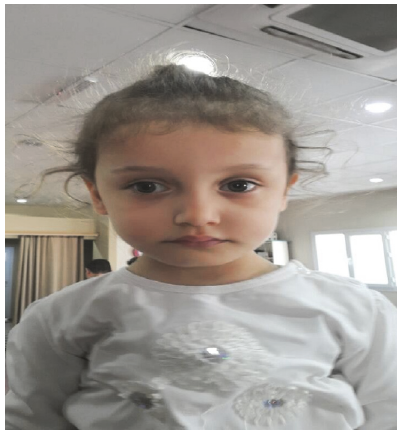
Figure 1: She was 32 months